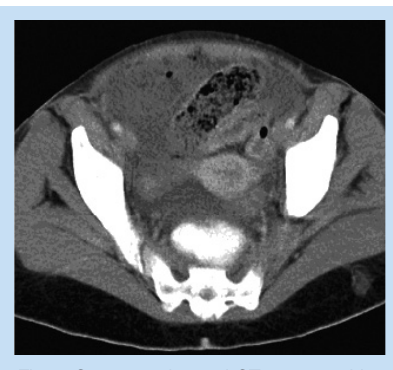
Fig. 7. Contrast-enhanced CT scan at mid to lower pelvis revealed